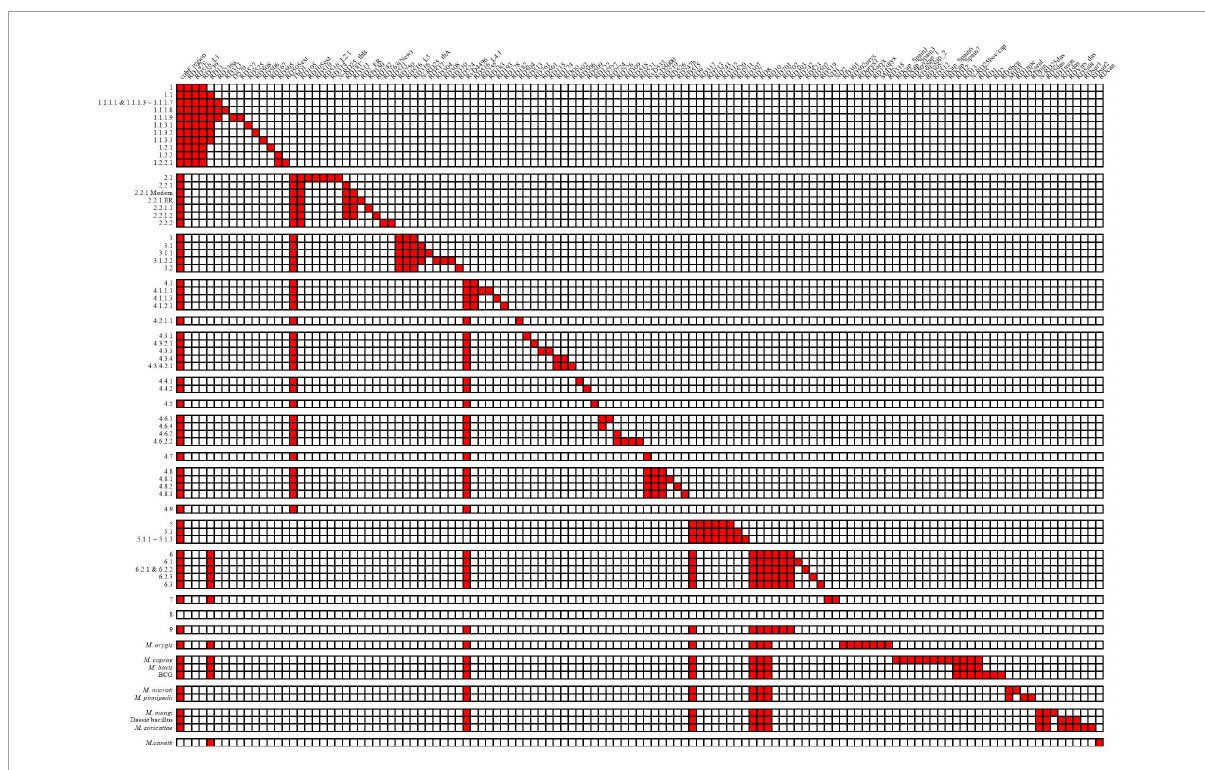
FIGURE3 Deletion patterns of RDs and RvDs within